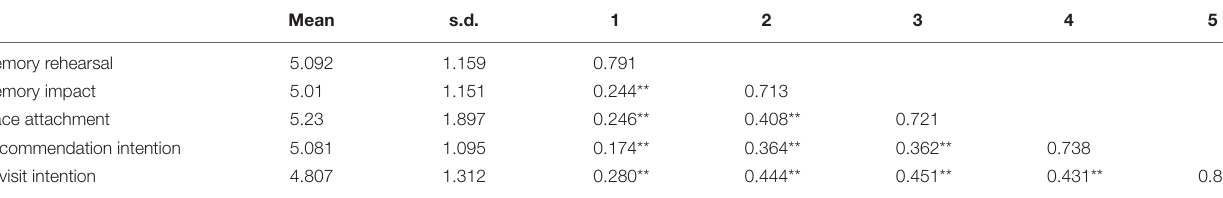
TABLE 2 | Means, SD, and correlations among